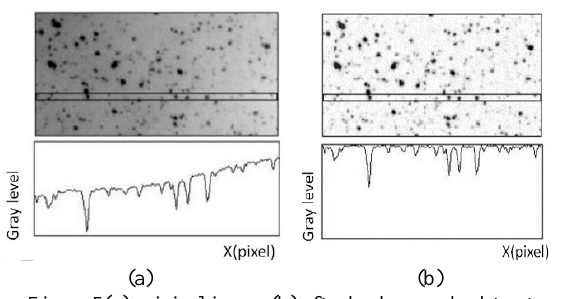
Figure 5(a) original image (b) after background subtract